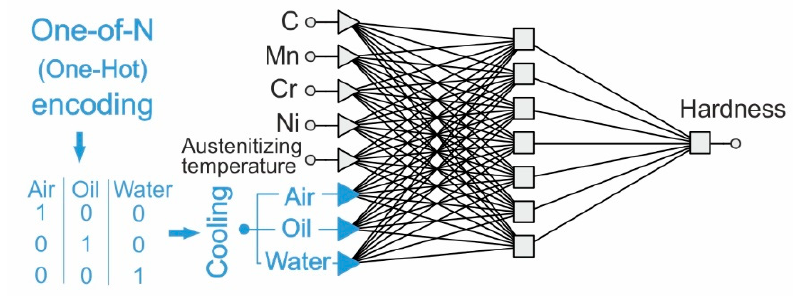
Figure 4. An example of coding the value of a qualitative variable with the one-of-N method.